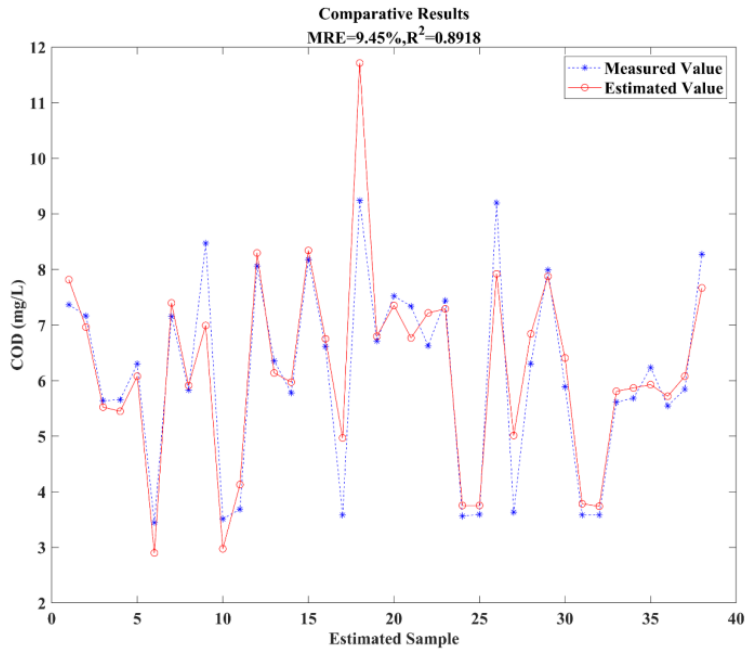
Figure 7. Comparative results of the SWQM model. The simulation results of the DWQM model are shown in Figure 8. The average relative error MRE = 8.21% and the absolute coefficient R 2 = 0.9110.